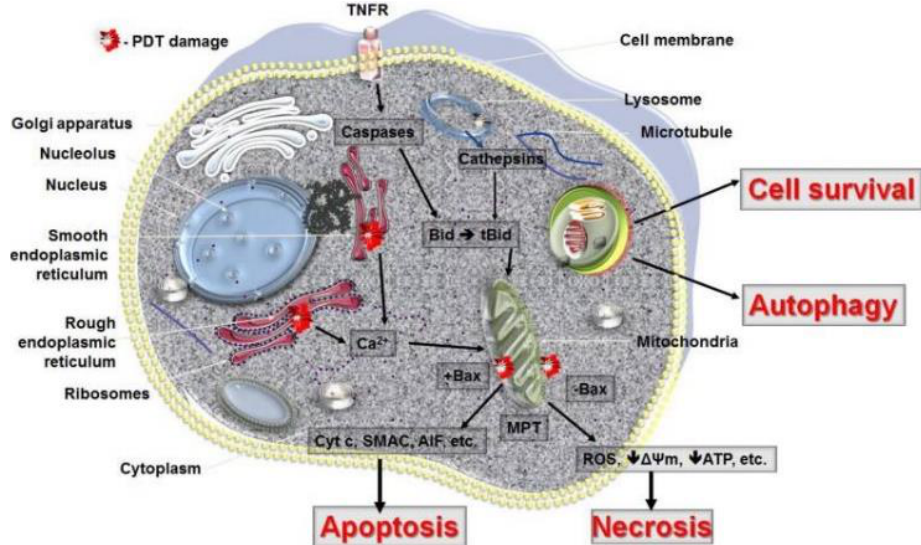
Figure 6. Cell death pathways in PDT. The mode of cell death observed after PDT depends to some extent on the intracellular localization of the PS and PDT-related damage to that organelle. PDT with PS localized in mitochondria will lead to loss of membrane permeability and release of pro-apoptotic mediators, while ER damage will release cellular deposits of calcium. PS that accumulates in lysosomes will release proteolytic enzymes upon illumination. Lysosomes may also fuse with autophagosomes to hydrolyse-damaged organelles and recycle them during autophagy. In the case of excess of damage, the cell will not survive despite the initiation of autophagy. Necrosis and autophagy may be dominant cell death modes after PDT when apoptosis is dysfunctional. It should be remembered that several PS may localize in more than one organelle, and the activation of cell death pathways may occur concurrently. Reproduced with permission from Pawel Mroz et al., Cancers; published by MDPI, 2011 [157].